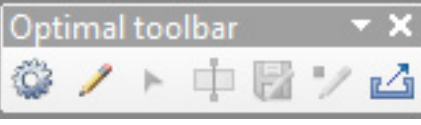
Figure 2. The Optimal